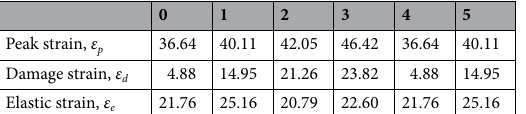
Table 2. Static compression strain statistics of rock specimens after different cumulative